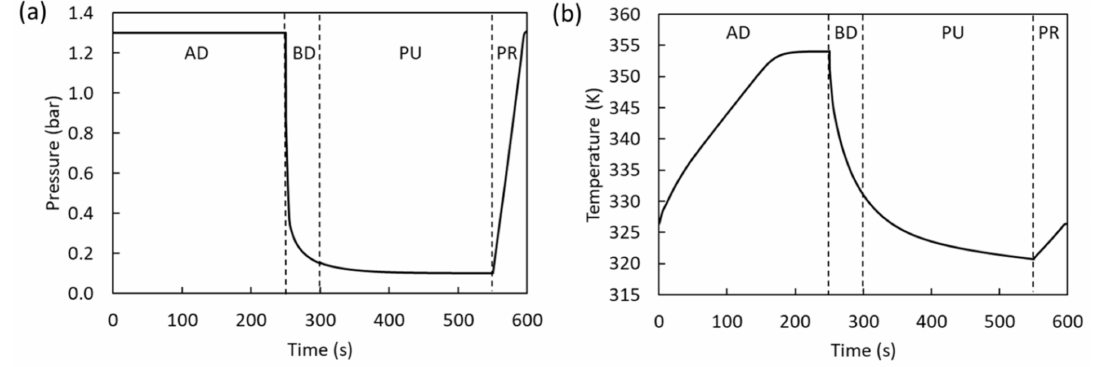
Figure 6. Profiles of ( a ) pressure and ( b ) temperature averaged over the bed length for a cycle at the cyclic steady state of the 2-bed, 4-step VPSA (Run